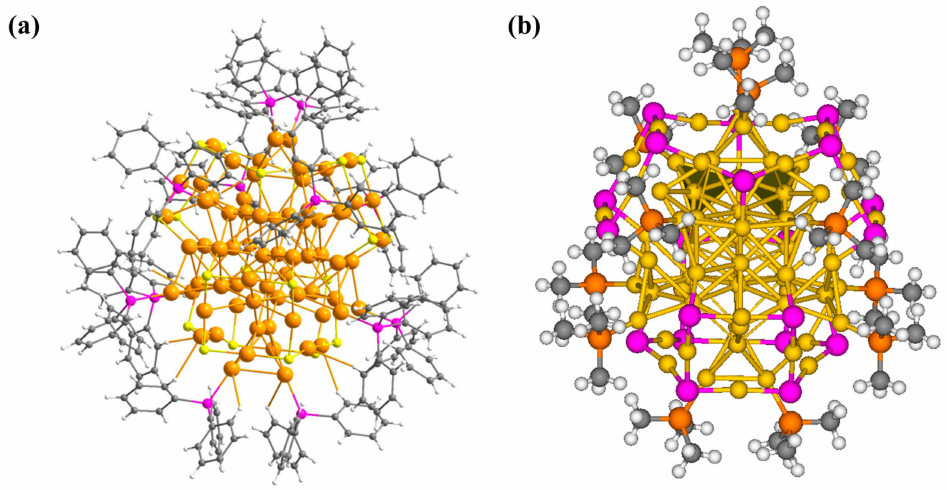
Figure 1. ( a ) Single crystal XRD structure of Au 70 S 20 (PPh 3 ) 12 from [21], reproduced with permission, Royal Society of Chemistry, 2017; ( b ) The optimized structure of Au 70 S 20 (PCH 3 ) 12 cluster. The cluster is obtained at the PBE0 / LanL2dz(Au) and 6-31G *(S, C, P, H) level of theory. Au, yellow, S, purple; P, orange; C, gray, H,